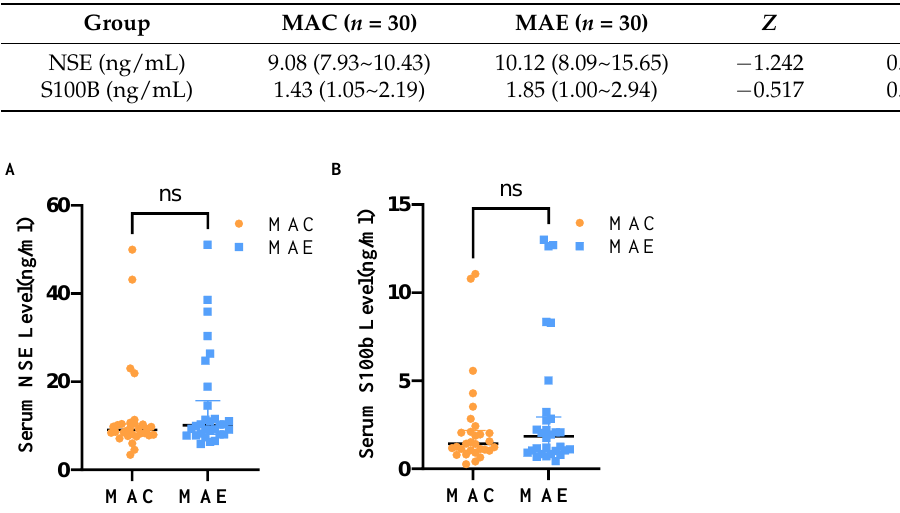
Table 2. Serum NSE and S100b levels in MAE and MAC groups.